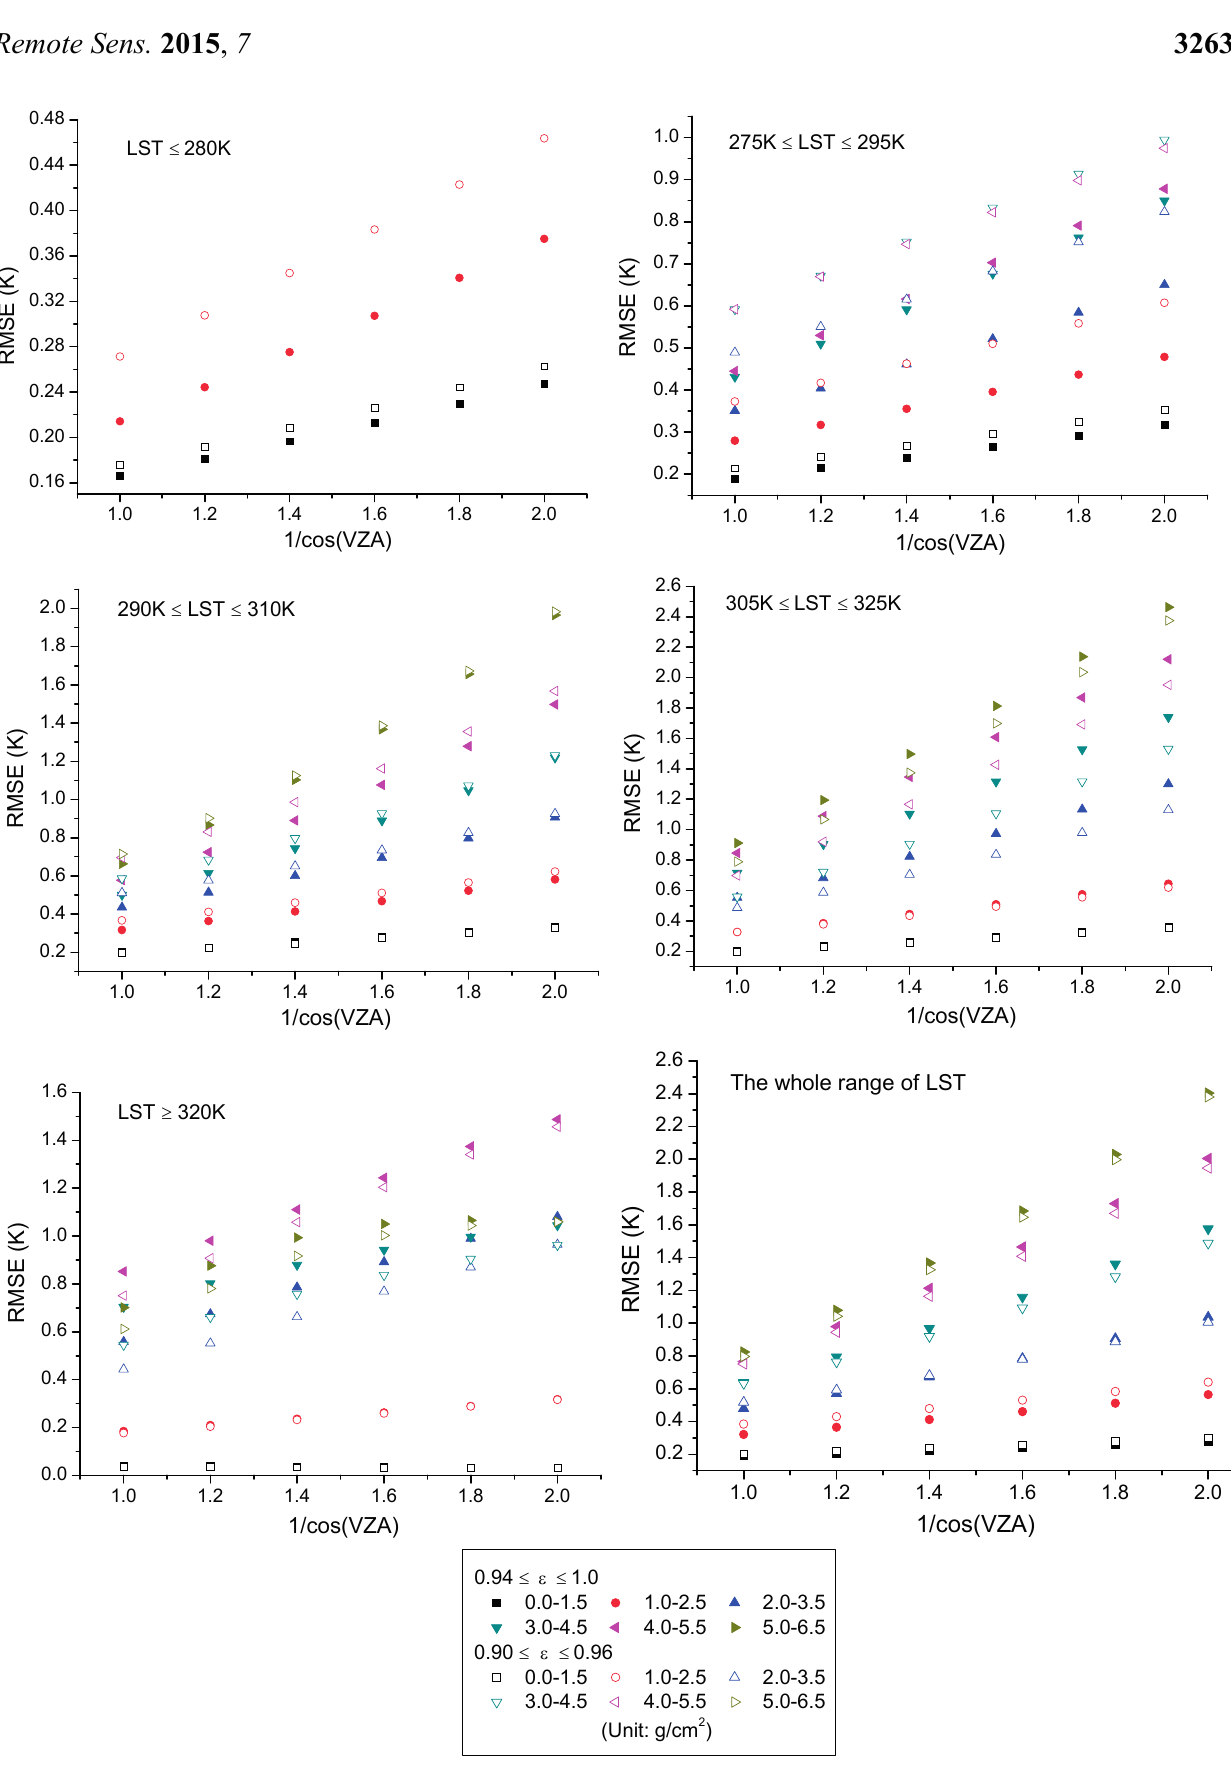
as functions of the secant VZA for (cid:3046)